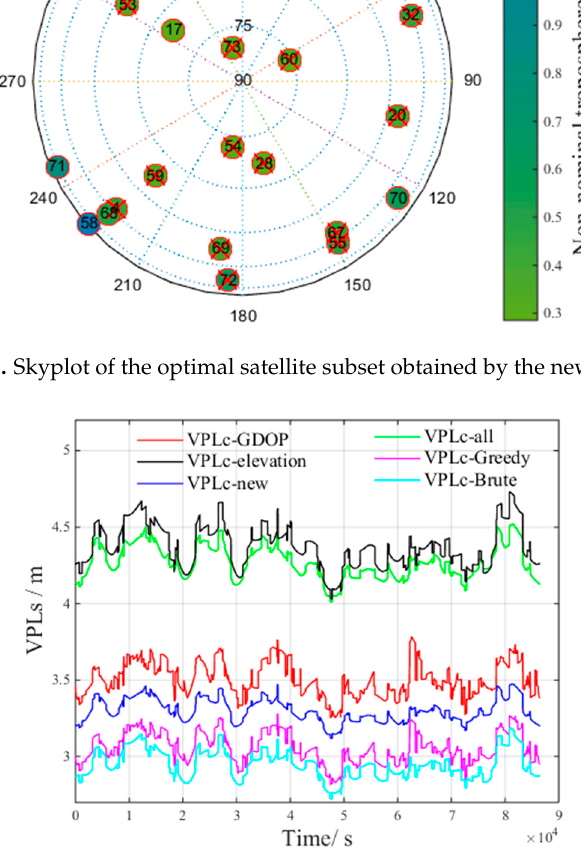
Figure 21. Skyplot of the optimal satellite subset obtained by the new method.